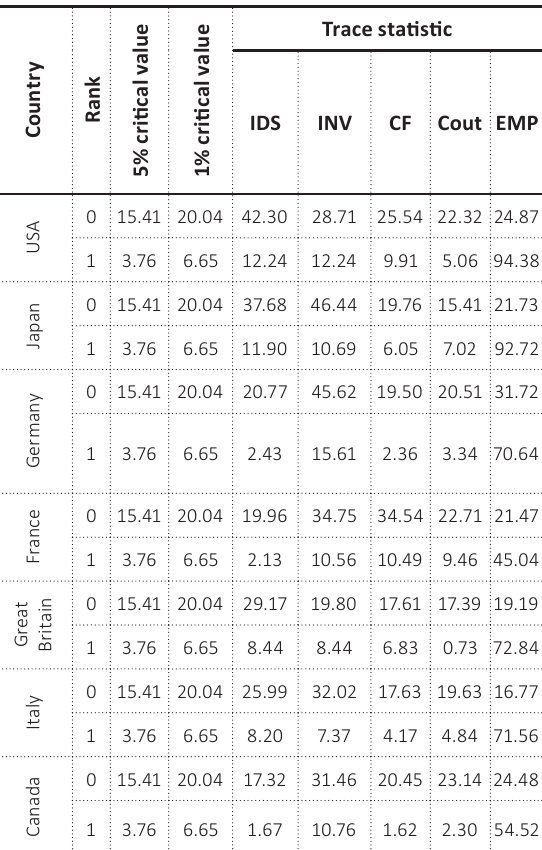
Table 6. Johansen tests for